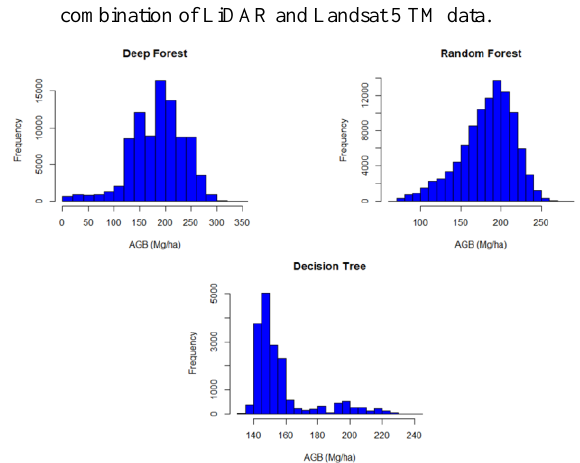
Figure 4 . Histograms of AGB maps for three tree-based regression models: deep forest, RF, and DT in HWF. The AGB maps were produced using decision tree-based models and the combination of LiDAR and Landsat 5 TM